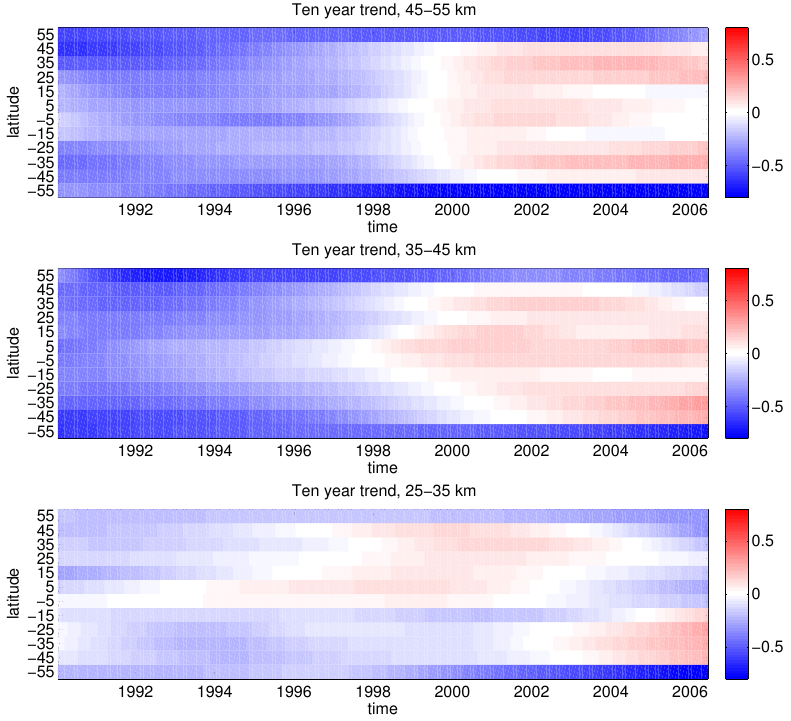
Figure 8. The 10-year trend in percentage change / year from the DLM fits for each altitude region and zonal band. One individual trend analysis is shown in the lower left panel of Fig. 2.